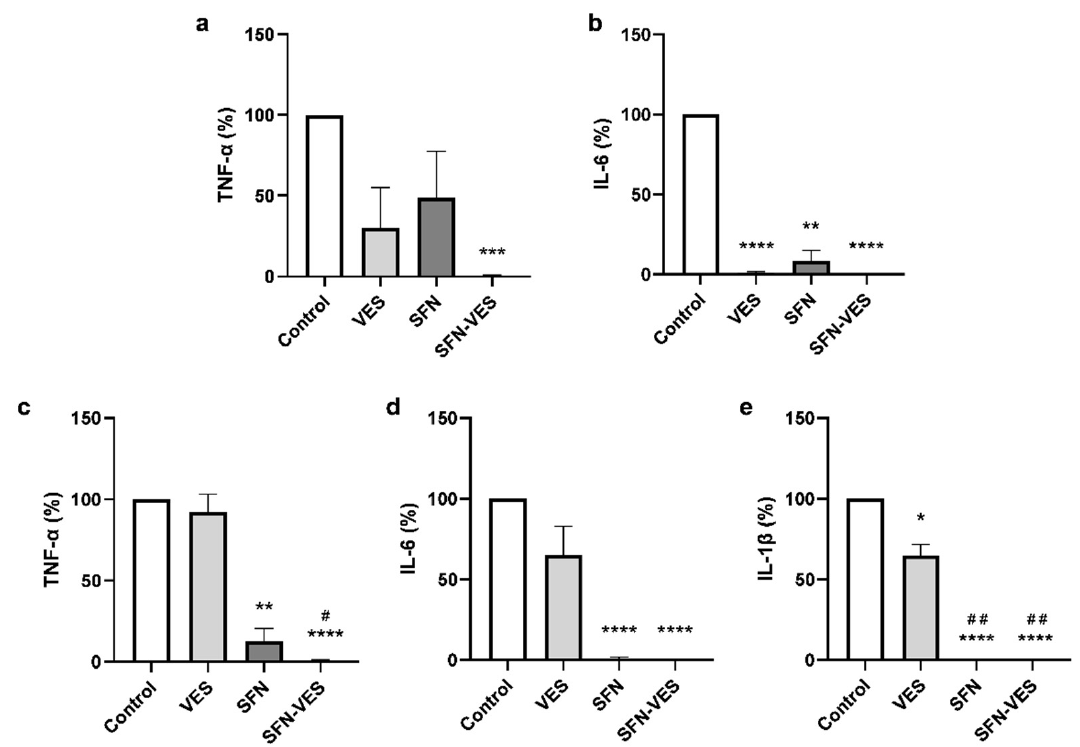
Figure 6. Cytokine production by M1 macrophages treated with SFN in its different formulations cultured in the presence of C. albicans . Unstimulated ( a,b ) or LPS stimulated ( c–e ) primary cultures of human M1 macrophages from 3 or 5 healthy donors, respectively, were untreated (control) or treated for 24 h with unloaded broccoli membrane vesicles 0.02 mg/mL (VES), free sulforaphane 25 µM (SFN), or SFN-loaded broccoli membrane vesicles at 25 µM (SFN-VES). After withdrawal of medium, the cells were cocultured for 2 h with C. albicans from exponential phase cultures, at 1:5 ratio (macrophage:yeast). Cytokine production was assessed in culture supernatants. Data were normalized relative to untreated control for each experimental condition (valued as 100%) and represented as mean ± SEM. Significant differences with respect to the untreated control (*) or VES treatment (#) were calculated according to the one-way ANOVA analysis with a Tukey’s test as a post hoc test (* p < 0.05, ** p < 0.01, *** p < 0.001, **** p < 0.0001; # p < 0.05, ## p <